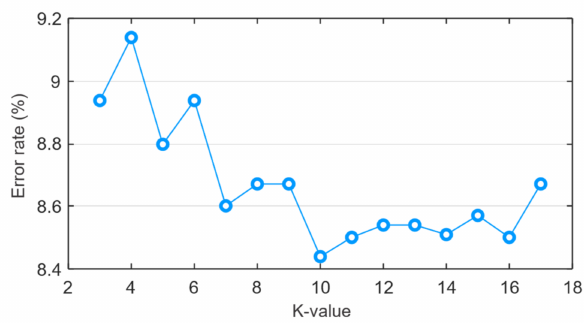
Figure 15. Number of neighbors vs Error rate for the Weighted